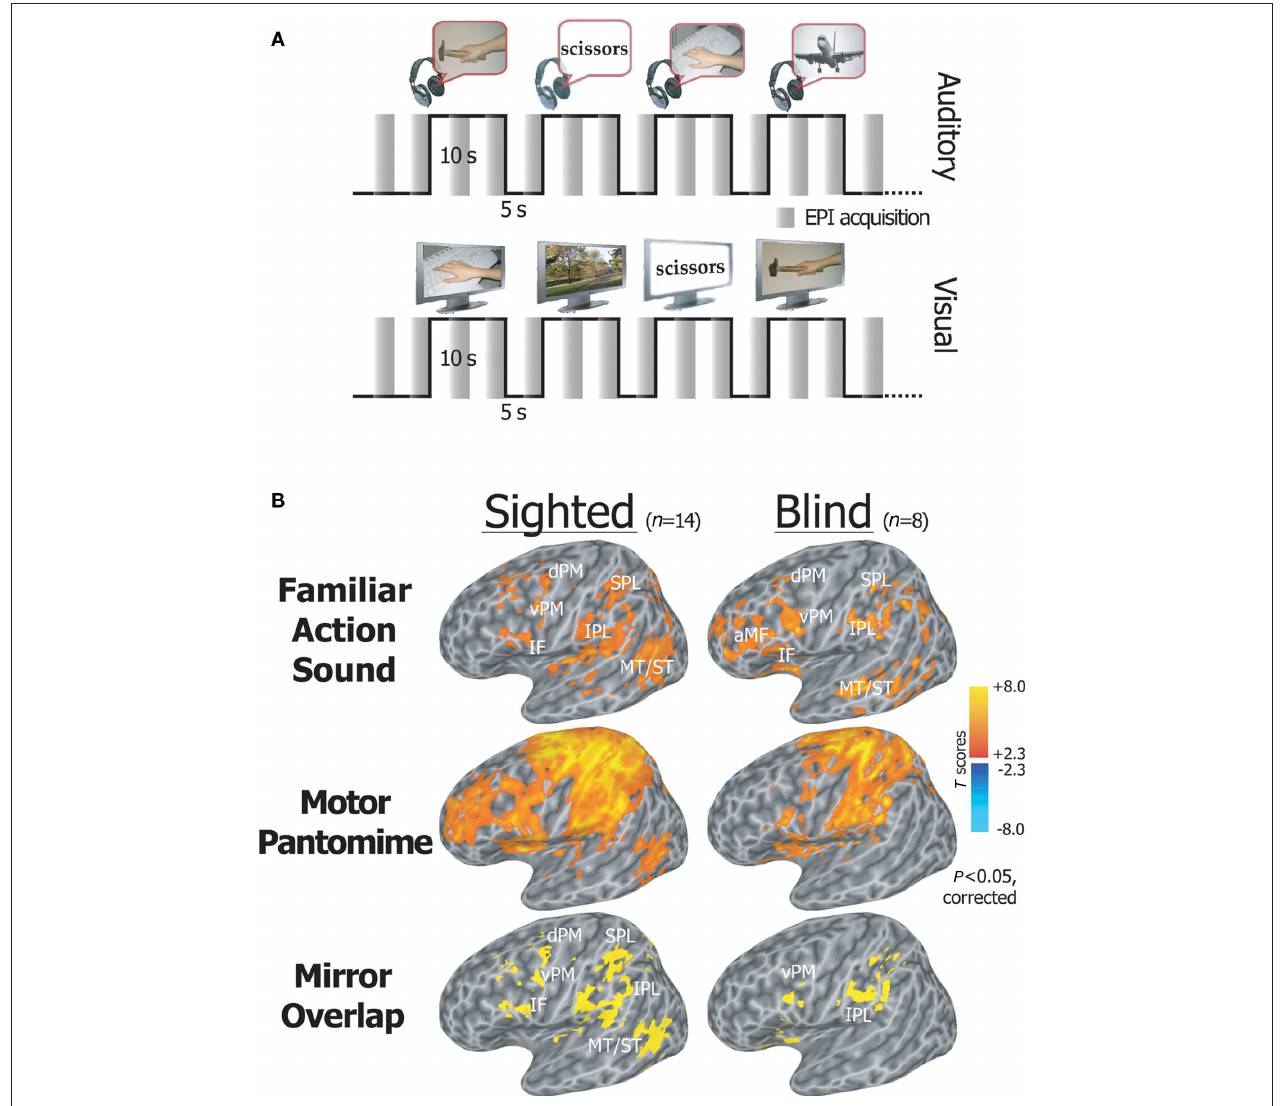
during the motor pantomime of action as compared to rest. Auditory mirror voxels are shown in yellow as overlap between the two task conditions (bottom row). Spatially normalized activations are projected onto a single-subject left hemisphere template in Talairach space. aMF, anterior middle frontal gyrus; IF, inferior frontal gyrus; vPM, ventral premotor cortex; dPM, dorsal premotor cortex; MT/ST, middle temporal and superior temporal cortex; IPL, inferior parietal lobule; SPL, superior parietal lobule (modified from Ricciardi et al.,